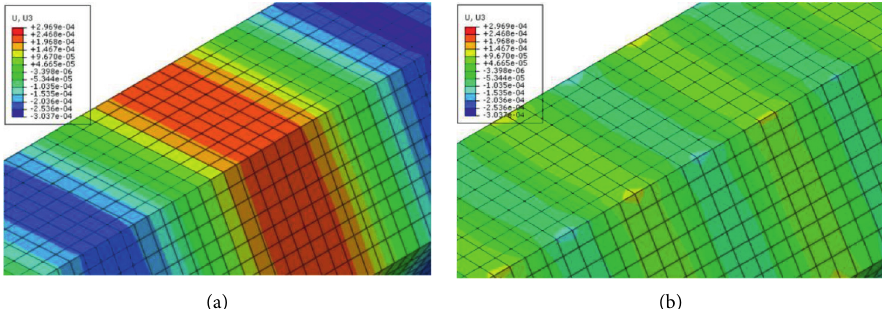
Figure 10: Contours of the displacement filed along the axial direction: (a) L (0, 2) mode and (b) L (0, 1) mode.